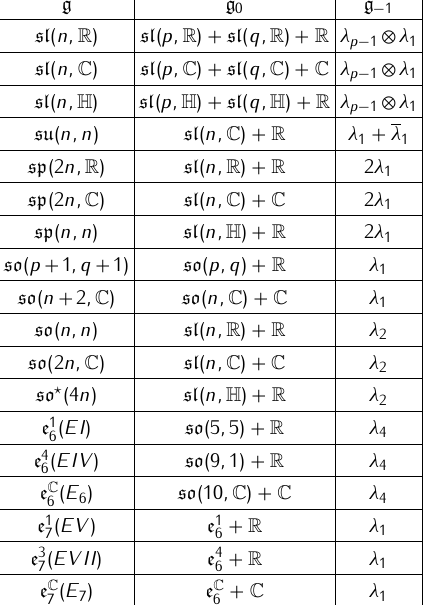
Table 1. Types of